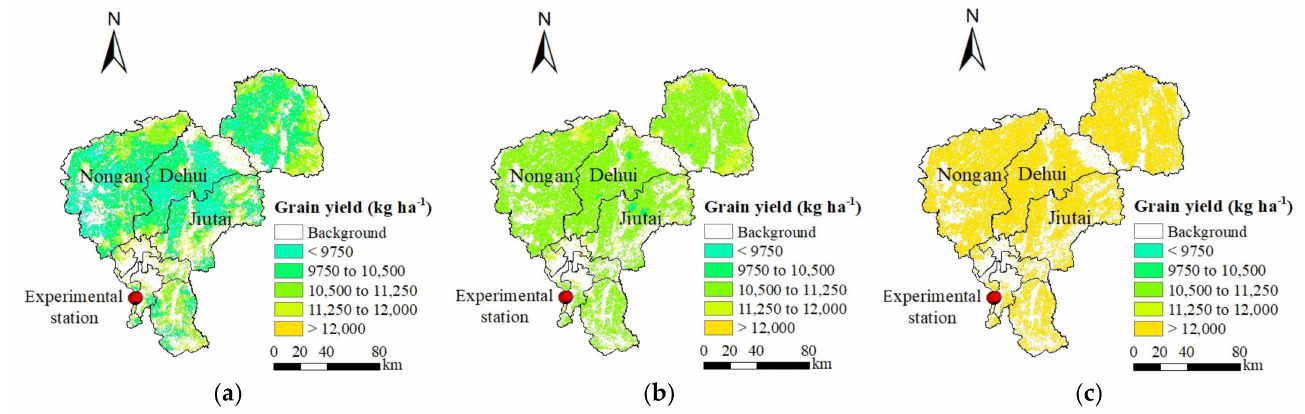
Figure 11. Forecasting results of grain yield using the N-logistic model calibrated in 2019 based on the field observations in three different days: ( a ) 2017/7/16; ( b ) 2017/8/10; ( c )